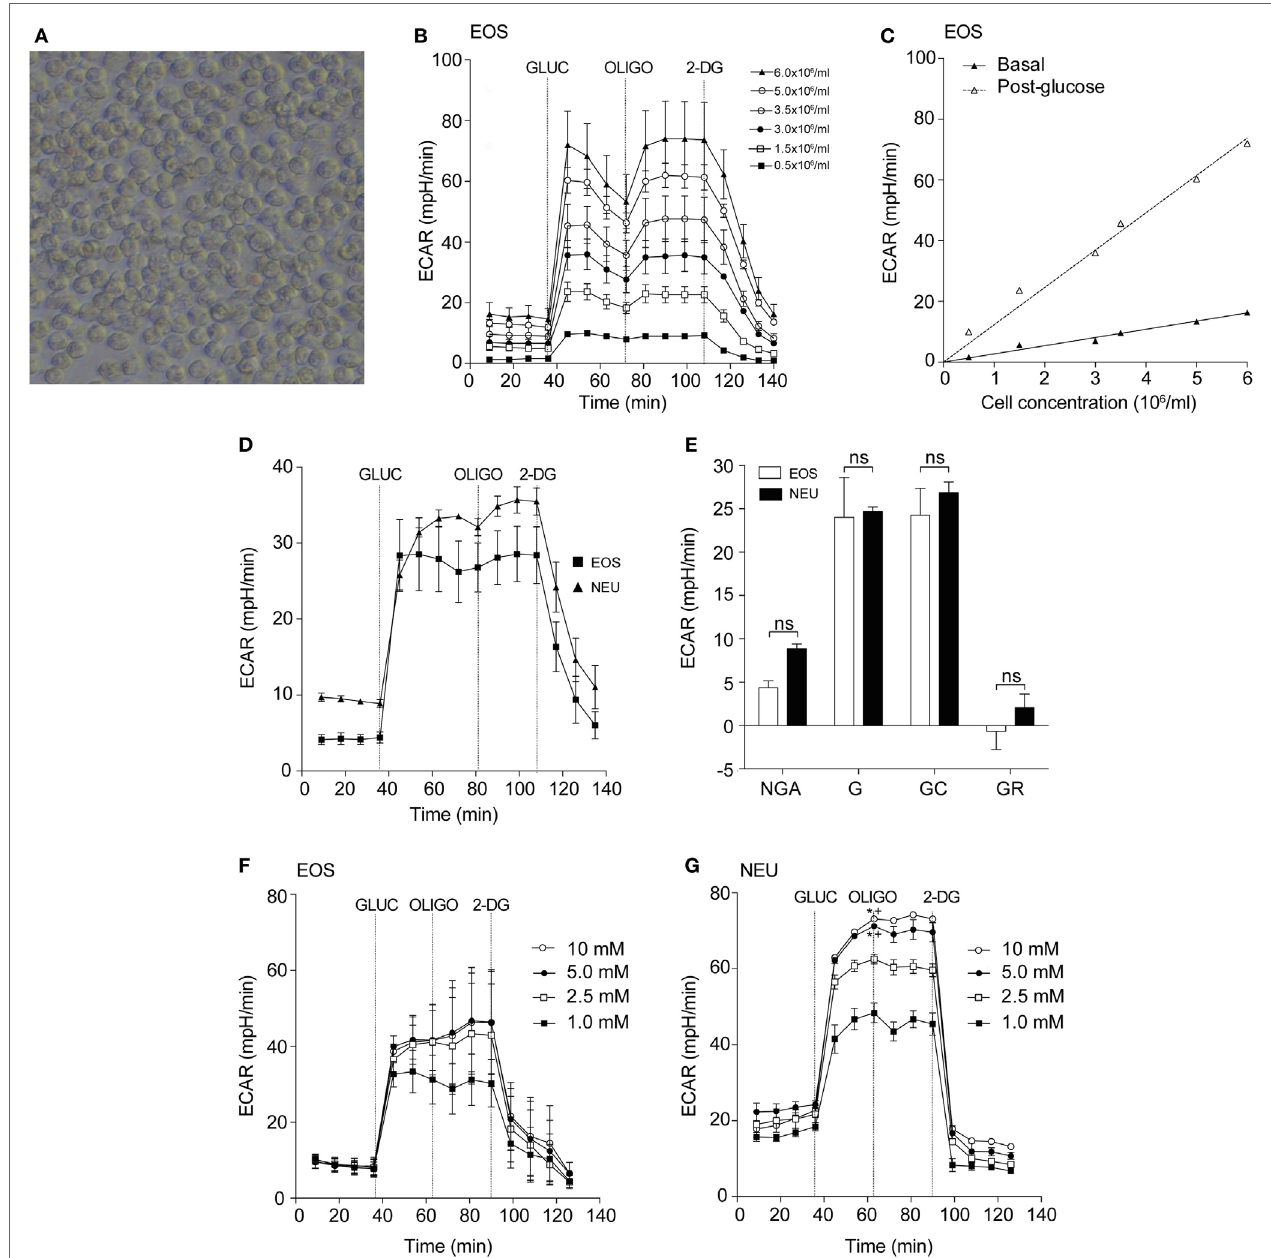
FigUre 1 | Optimization of eosinophil seeding density and measurement of glycolysis in eosinophils and neutrophils. (a) Representative light microscopy of eosinophils (3 × 10 6 /ml) adhered to a Cell-Tak-coated 96-well plate for 1 h. Magnification 40 × . (b) Kinetic extracellular acidification rate (ECAR) response of eosinophils to glucose injection at 36 min (GLUC, 10 mM), the mitochondrial ATP synthase inhibitor oligomycin (OLIGO) injection at 72 min (OLIGO, 2.5 µM), and the inhibitor of glucose 2-DG (100 mM) injection at 108 min, using 0.5–6 × 10 6 eosinophils/ml. Data represent the mean of a single experiment with ± SD of triplicate wells. (c) Eosinophil seeding density titration using basal and post-glucose ECAR levels. Data represent the mean ± SD of a single experiment. (D) Kinetic ECAR response of eosinophils (black squares) and neutrophils (black triangles) to stimulation with glucose (GLUC) at 36 min, OLIGO at 81 min, and 2-DG at 108 min. Data represent the mean ± SEM of three independent experiments. Eosinophil and neutrophil ECAR responses were measured simultaneously on the same assay plate. (e) Measurement of glycolytic rates in eosinophils (white bars) and neutrophils (black bars). Non-glycolytic acidification (NGA), glycolysis (G), glycolytic capacity (GC), and glycolytic reserve (GR). Data represent the mean ± SEM of three independent experiments, analyzed using one-way ANOVA test with Tukey post hoc test. Ns indicates a non-significant difference. (F) Eosinophil ECAR following stimulation with glucose (GLUC) (1–10 mM) at 36 min, OLIGO (2.5 µM) at 72 min, and 2-DG (100 mM) at 90 min. Data represent the mean ± SEM of three independent experiments, analyzed using one-way ANOVA with Tukey post hoc test. (g) Neutrophil ECAR following stimulation with glucose (GLUC) (1–10 mM) at 36 min, OLIGO (2.5 µM) at 72 min, and 2-DG (100 mM) at 90 min. Data represent the mean ± SEM of three independent experiments, analyzed using one-way ANOVA test with Tukey post hoc test. * p < 0.05 compared with 1 mM glucose and + p < 0.05 compared with 2.5 mM glucose. Eosinophil and neutrophil ECAR responses were measured simultaneously on the same assay plate (F,g)